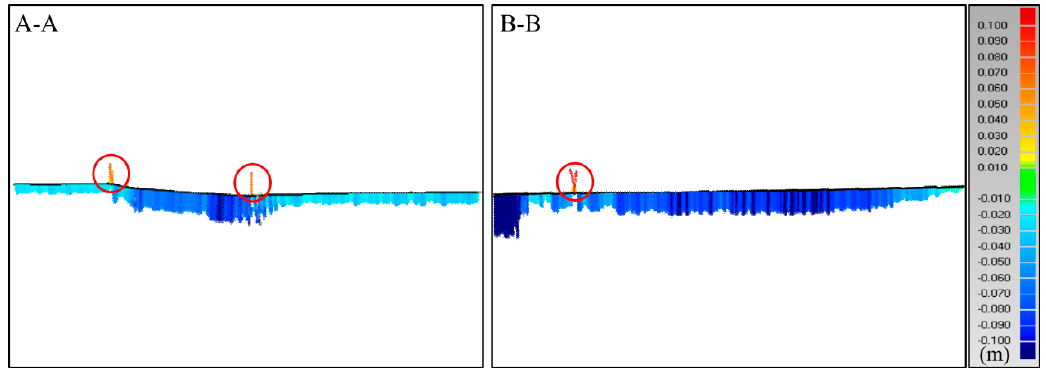
Figure 9. The deformation distribution along the two cross ‐ sections.